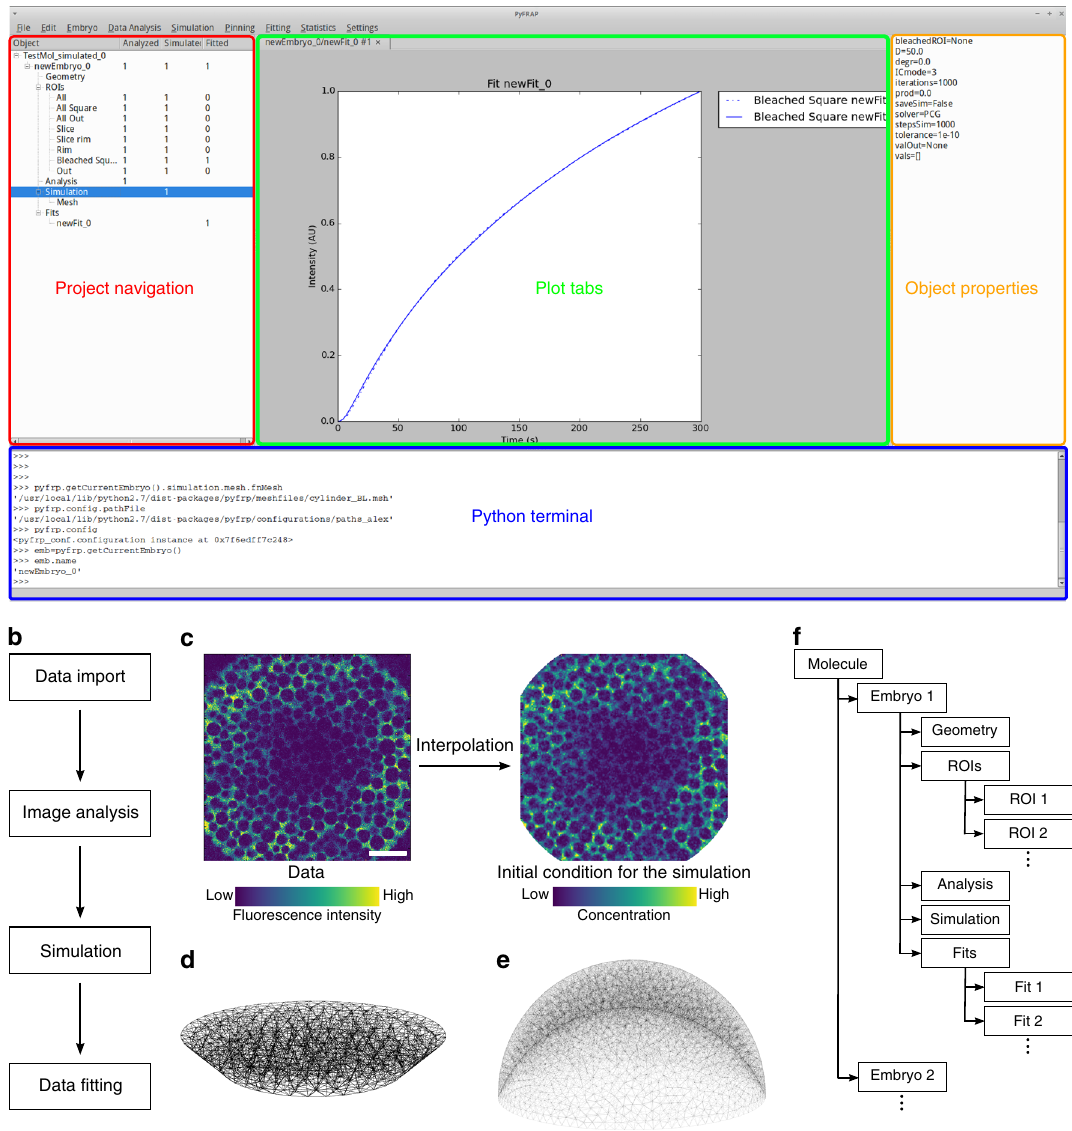
Fig. 2 The PyFRAP software package. a Annotated snapshot of the PyFRAP main GUI with project navigation tree (red), plot tabs (green), object property display (orange), and integrated Python terminal (blue). b PyFRAP work fl ow. c PyFRAP ’ s interpolation of the fi rst post-bleach image as initial condition for FRAP simulations. The length of the white scale bar represents 100 μ m. d , e Spatial discretisation of geometries resembling d a frustum and e a zebra fi sh embryo at late blastula stages (dome stage). f PyFRAP ’ s data